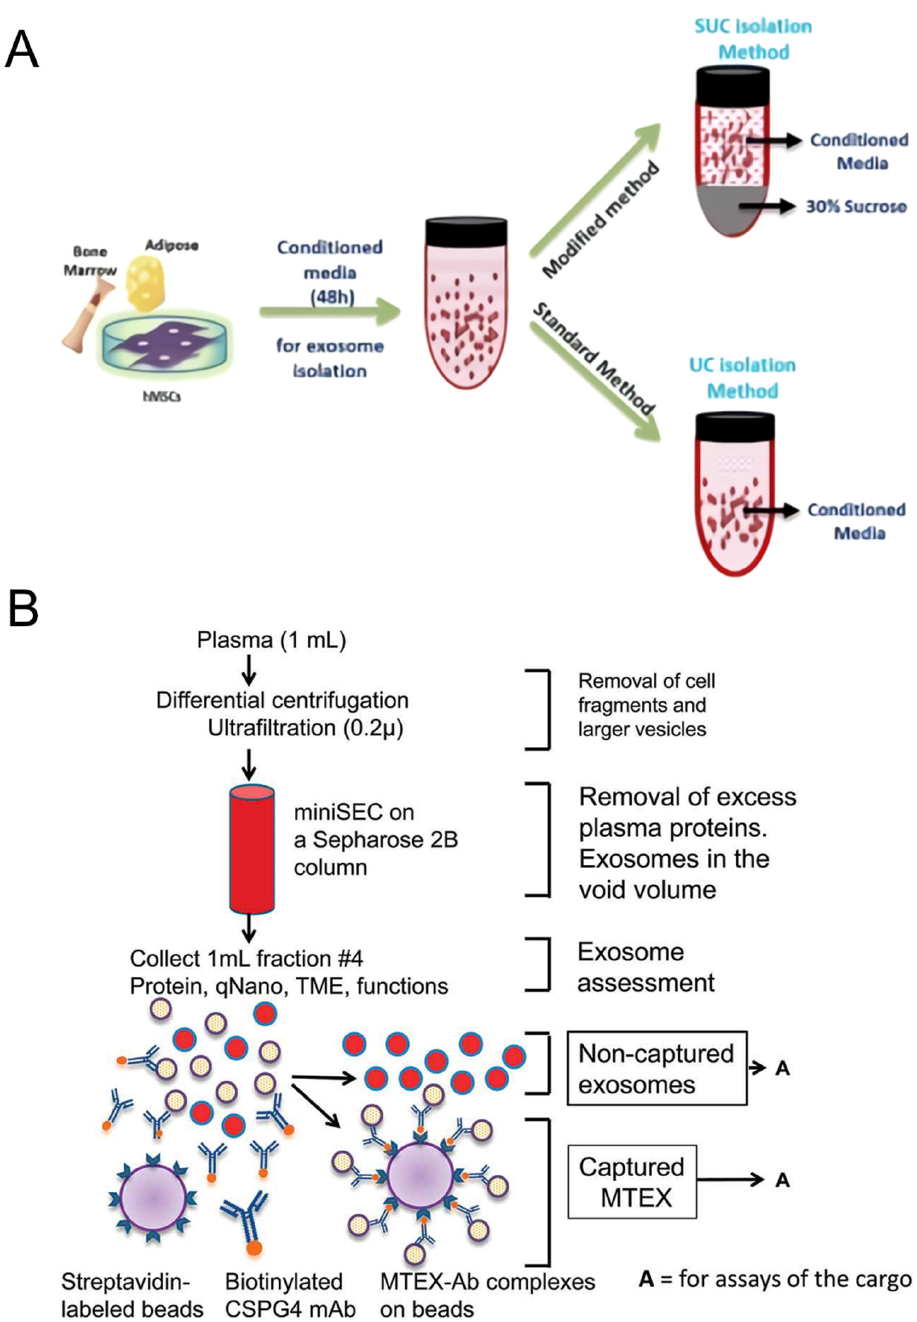
Figure 1. ( A ) Ultracentrifugation and sucrose cushion ultracentrifugation processes to isolate exosomes from stem cell cultures, ( B ) schematic diagram of an immunoaffinity-based separation process to precisely capture melanoma-derived exosomes. This was reproduced with permission from [80], published by Nature, 2018, and reprinted with permission from [81]. Copyright 2018, Taylor & Francis.